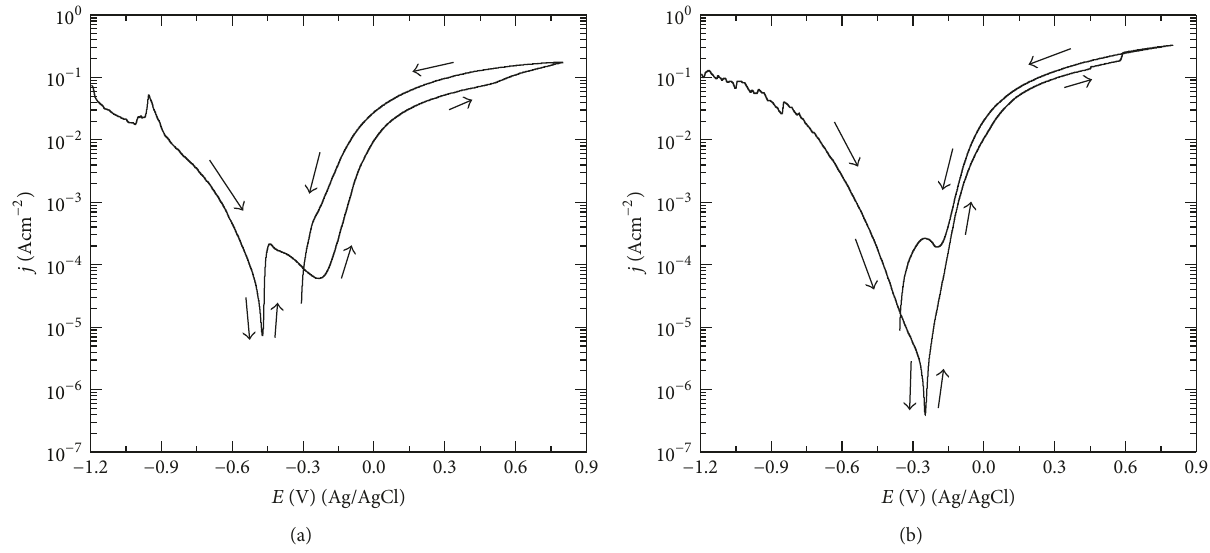
Figure 1: Cyclic potentiodynamic polarization curves obtained for ( 1 ) Fe-36% Ni and ( 2 ) Fe-45% Ni alloys in 1M HCl solutions.